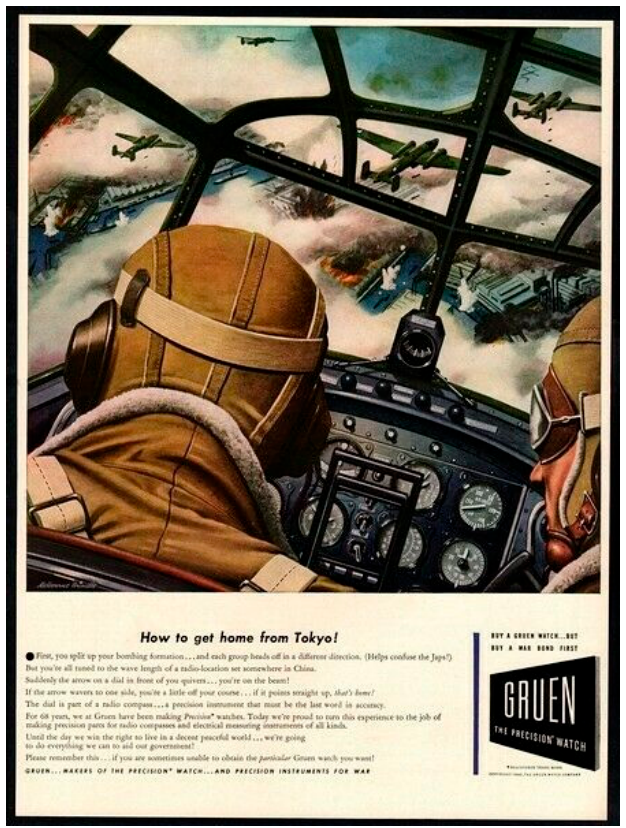
Figure 2. Gruen watch advertisement, 1942. In public domain.